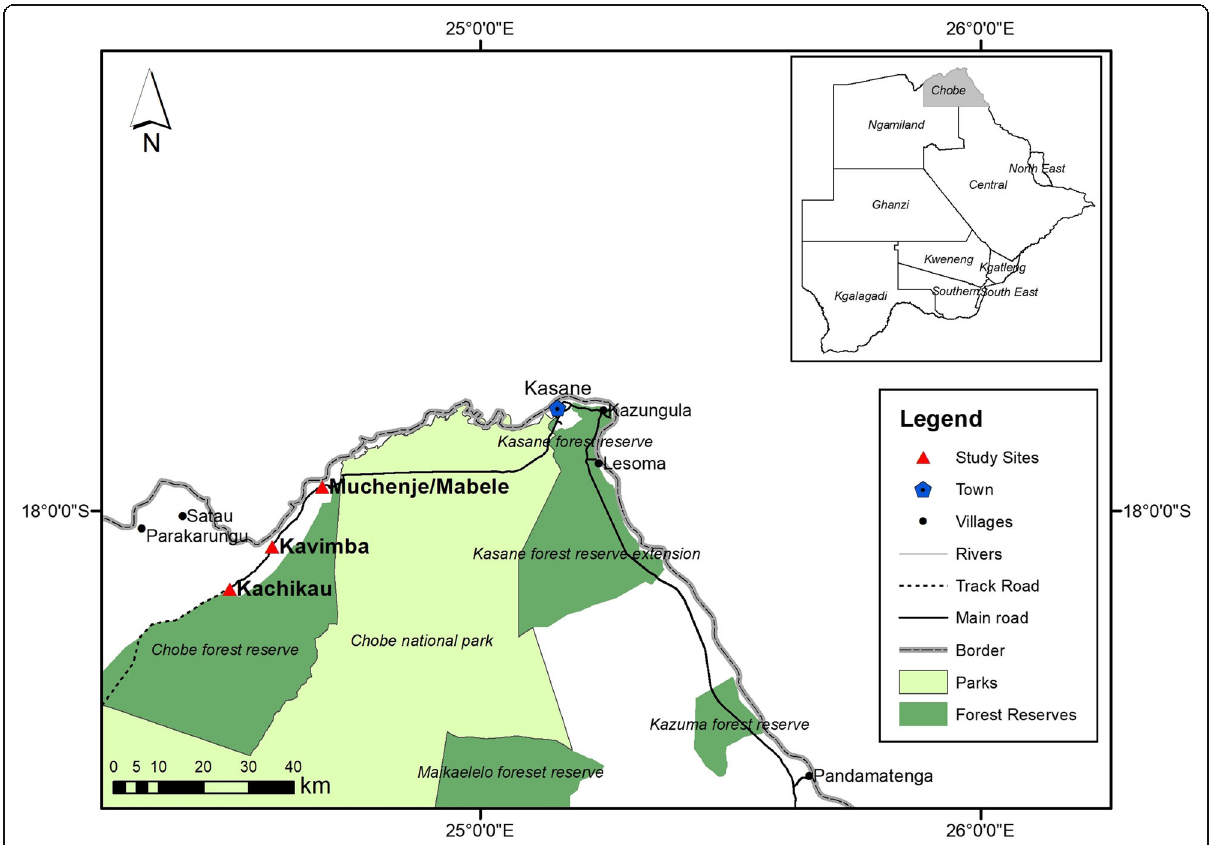
Fig. 1 Map of Chobe district depicting study